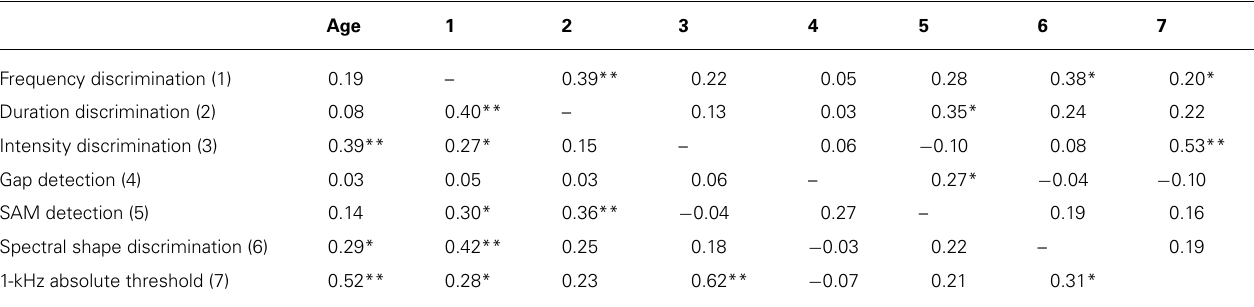
Table 2 | Correlation matrix between age and the auditory